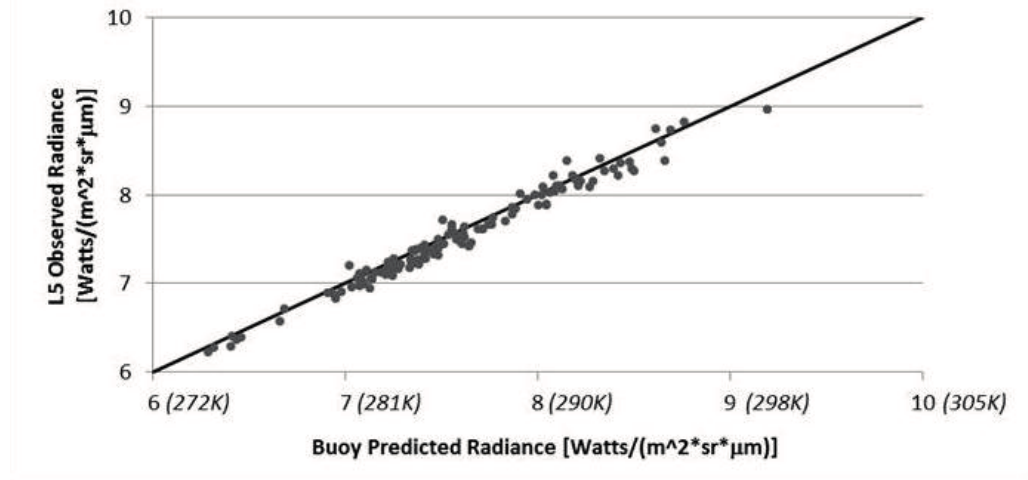
Figure 7. Plot of ToA buoy predicted radiance vs. satellite observed radiance for Landsat 7 for all data processed automatically (mean error − 0.24 K ± 0.81